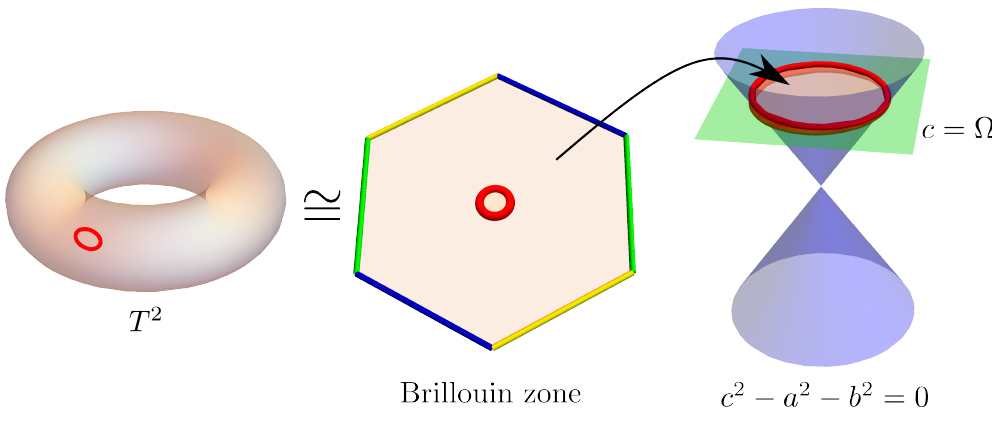
Figure 8: Left / Middle: The Brillouin zone with a puncture at k = 0. A loop (red) around the puncture, when shrunk to the origin, is mapped to a loop winding twice around the surface of the cone. The rest of the Brillouin zone is not defective and so does not map to the surface of the cone. Right: The set of defective hamiltonians form a cone (blue), with the frequency Ω dictating the height